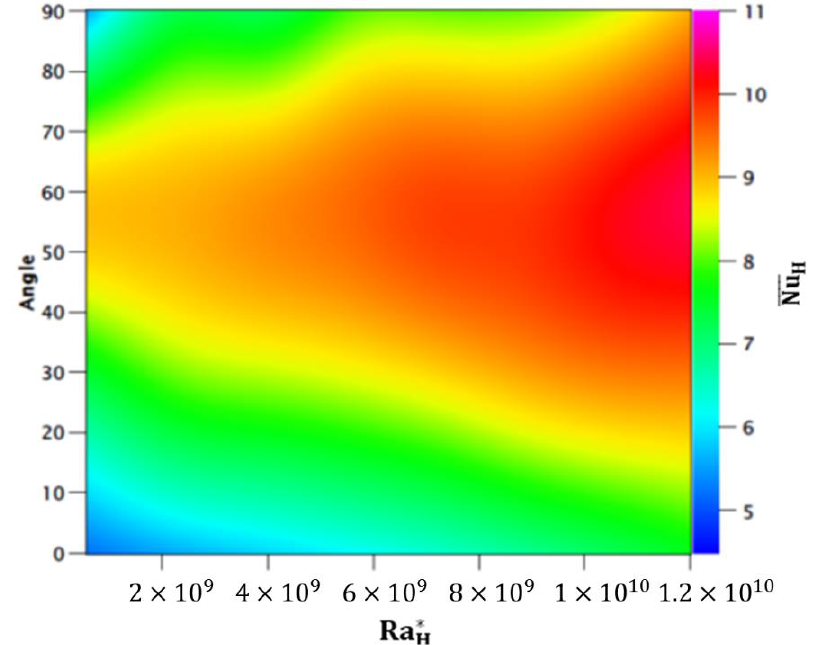
Figure 11. Nu and 𝐑𝐚 𝐇∗ contour at the four tilt angles of the cavity: 0°, 30°, 60°, and 90°.